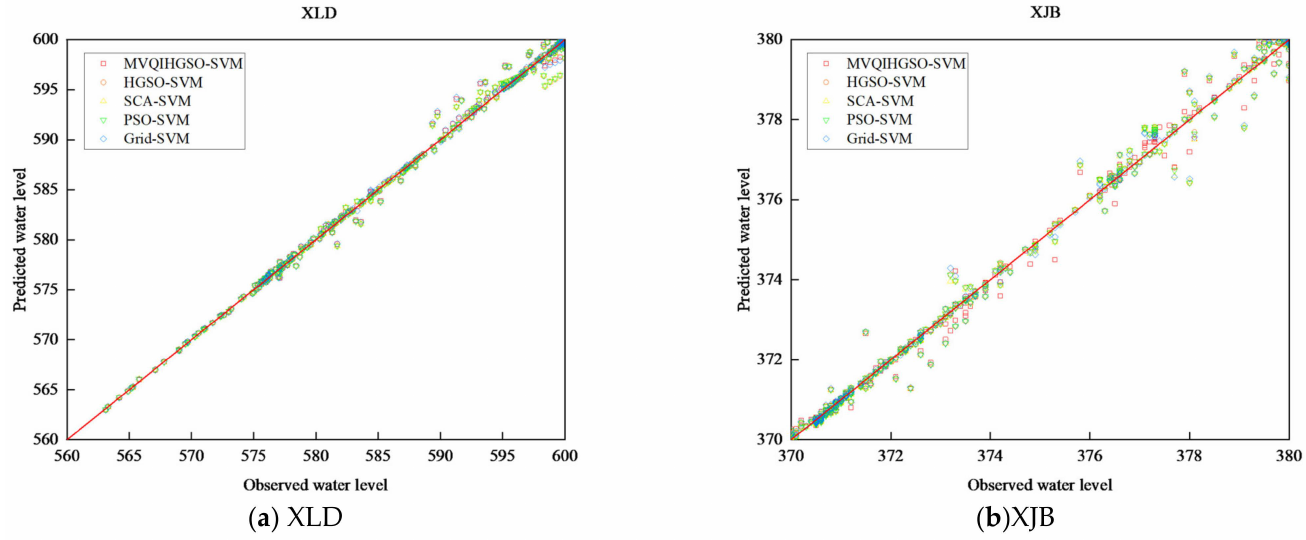
Figure 4. Scatter plots of all hybrid models in the validation set (unit: